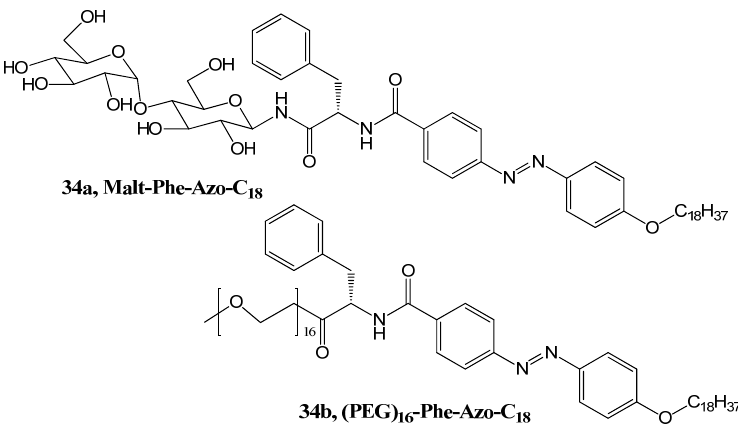
Figure 22. Maltose and PEG derived amphiphiles containing azobenzene.